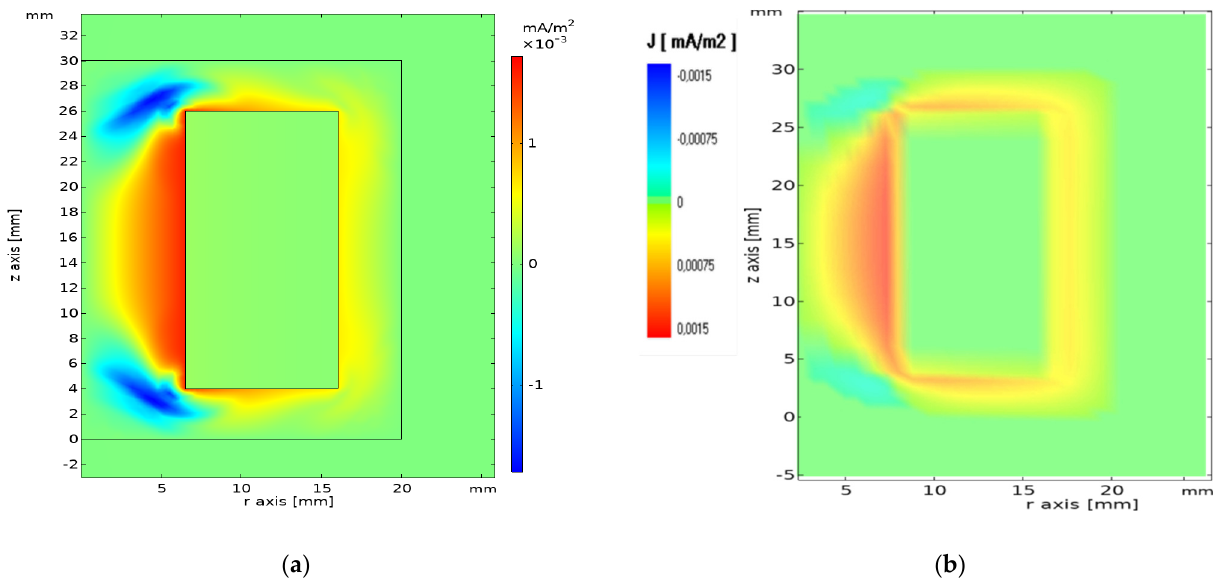
Figure 21. ( a ) Distribution of the displacement current density in the ferrite core at time t = 0.92 ms obtained by Comsol Mutliphysics. ( b ) Distribution of the displacement current density in the ferrite core at time t = 0.92 ms obtained by the proposed approach.